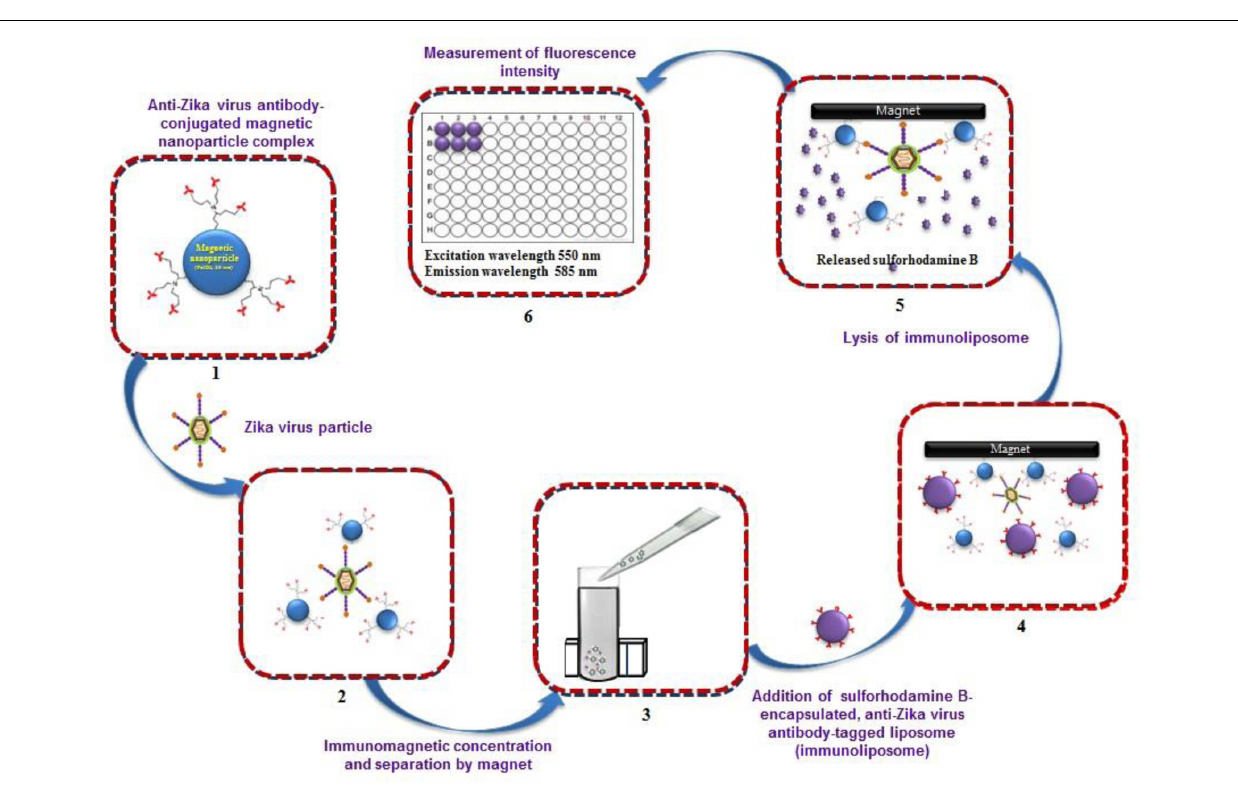
and fluorescence signal generation, as the principle of the developed assay discussed in our earlier research (Shukla et al.,